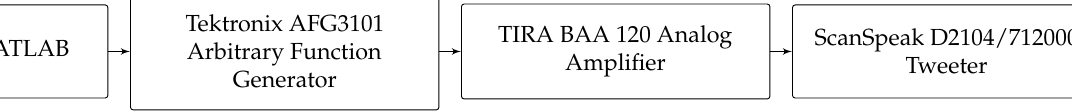
Figure 6. Block diagram of the signal generation